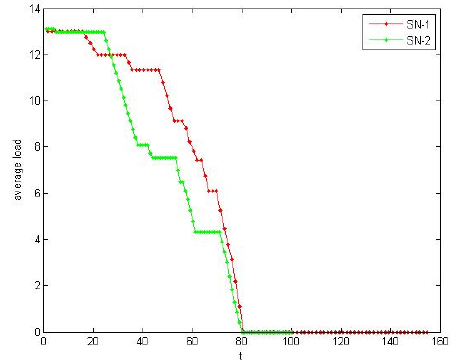
Figure 17. The contrast of absorptive capacity.